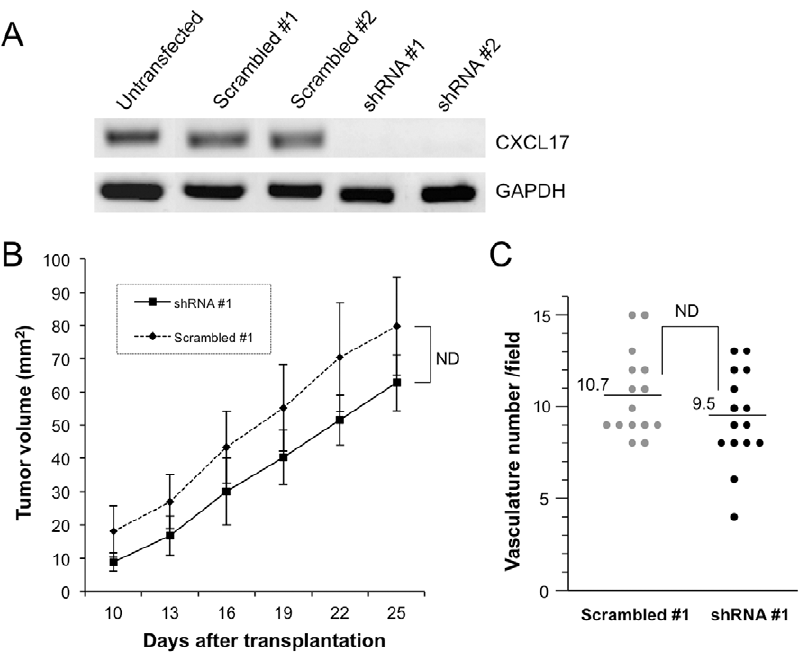
Figure 4. Tumorigenic effect of CXCL17 knockdown in HT-29 cells. (A) Two candidate sequences for shRNA for knocking down CXCL17 expression (shRNA # 1 and # 2) and corresponding scrambled sequences were also designed (Scrambled # 1 and # 2). Stable cell lines were isolated and knockdown levels of CXCL17 mRNA were analyzed using RT-PCR. Upper panel, CXCL17; lower panel, GAPDH as an internal control. (B) CXCL17- knockdown HT-29 cells (1 6 10 6 ) were transplanted into the subcutaneous space of SHO mice and tumor size was measured at the indicated time points. There was no significant difference between shRNA # 1 and Scrambled # 1. ND, not different; P=0.08 (n=4), One of two independent experiments with similar results is shown. (C) CD31-positive vessels of tumors in xenografts of CXCL17-knockdown HT-29 cells were counted in five random sections. ND, not different (P=0.19). One of two independent experiments with similar results is shown.